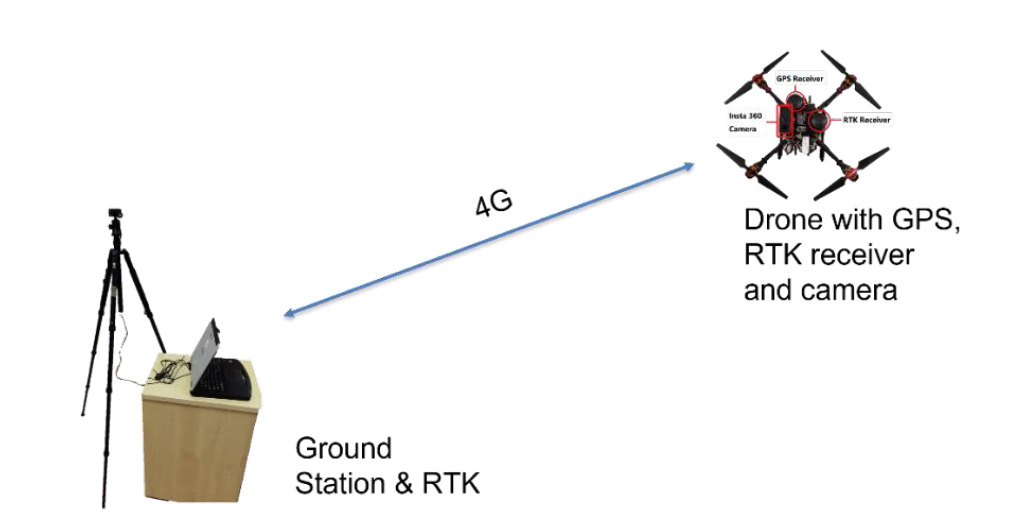
Figure 5. Tarot Ironman 650 with GPS Receiver, RTK Receiver and Insta 360 Camera Facing Upwards.